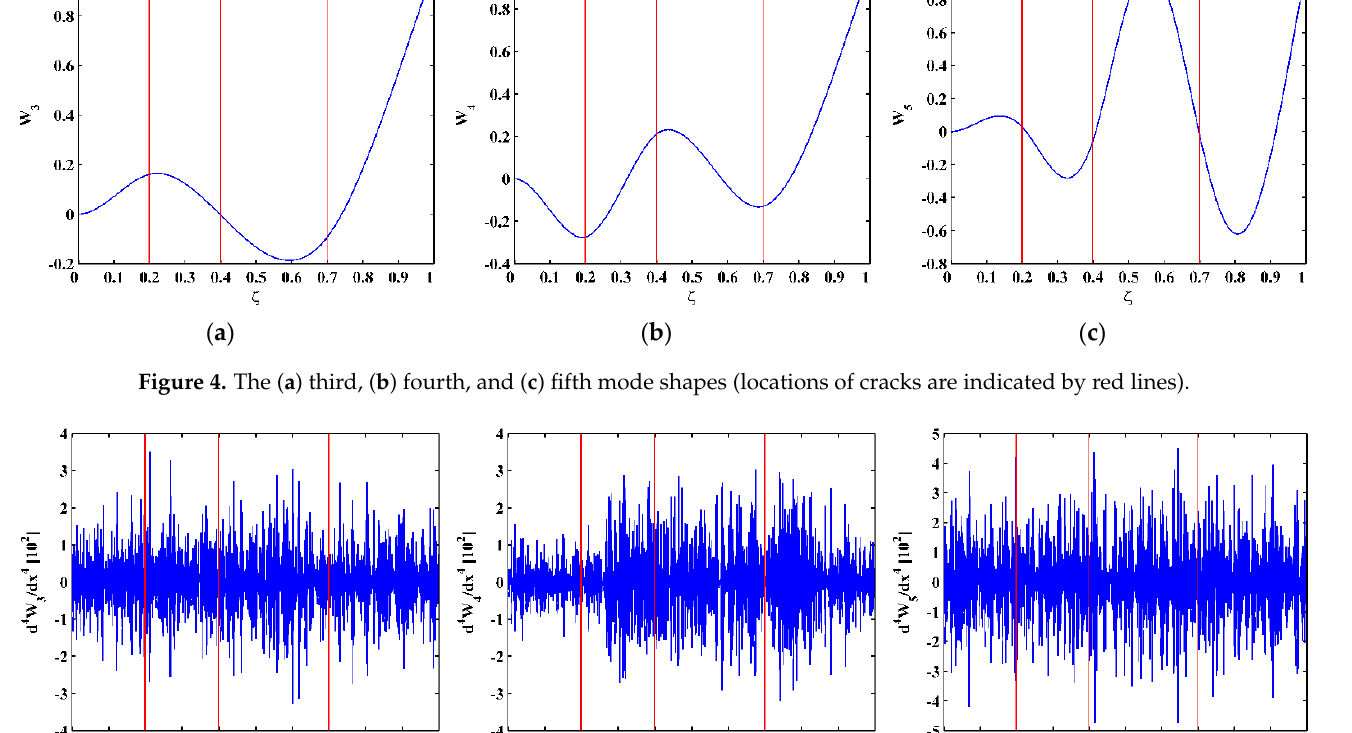
( c ) Figure 6. Derivatives of the ( a ) third, ( b ) fourth, and ( c ) fifth multi-scale mode shapes (locations of cracks are indicated by red lines).